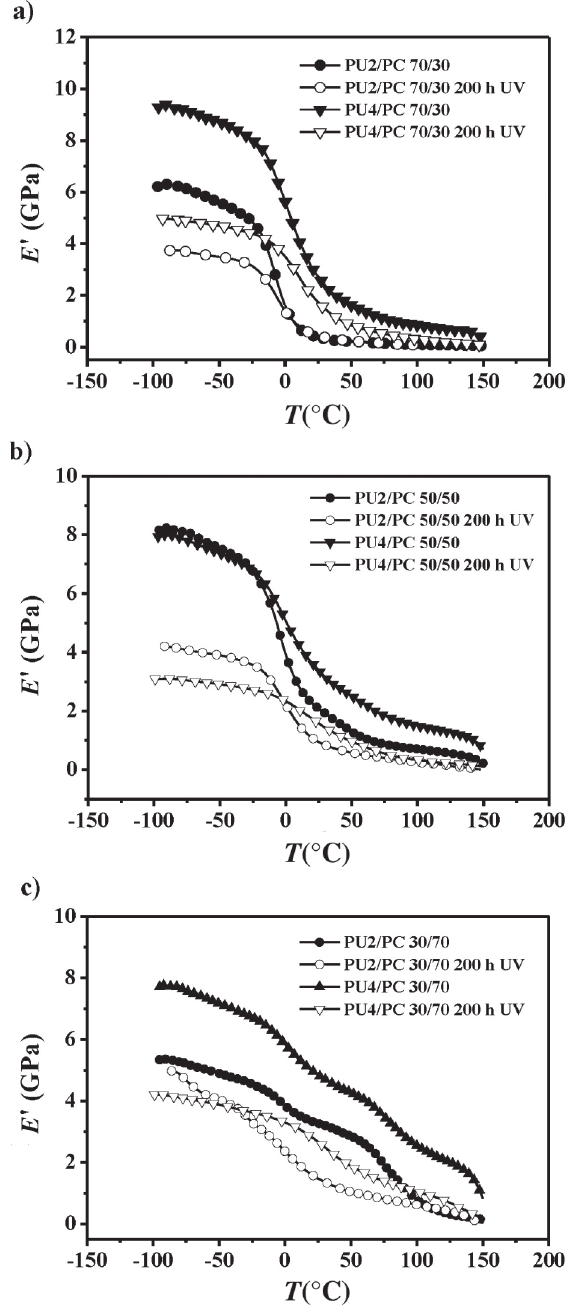
Fig. 6 – Storage modulus (E’) for PU/PC a) 70/30, b) 50/50, and c) 30/70 blends as a function of temperature before and after UV irradiation